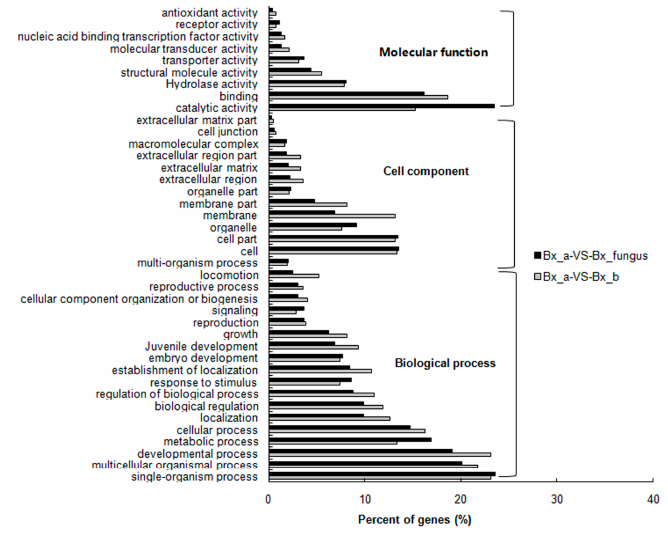
Figure 1. Gene Ontology (GO) terms for the transcriptome sequences derived from differently treated B. xylophilus ( p < 0.05). Gray bars indicate significantly enriched GO terms in endobacterium-treated PWN samples (Bx_b) compared to aseptic PWNs (Bx_a); black bars indicated significantly enriched GO terms in fungus PWNs (Bx_fungus) compared to aseptic PWNs (Bx_a).